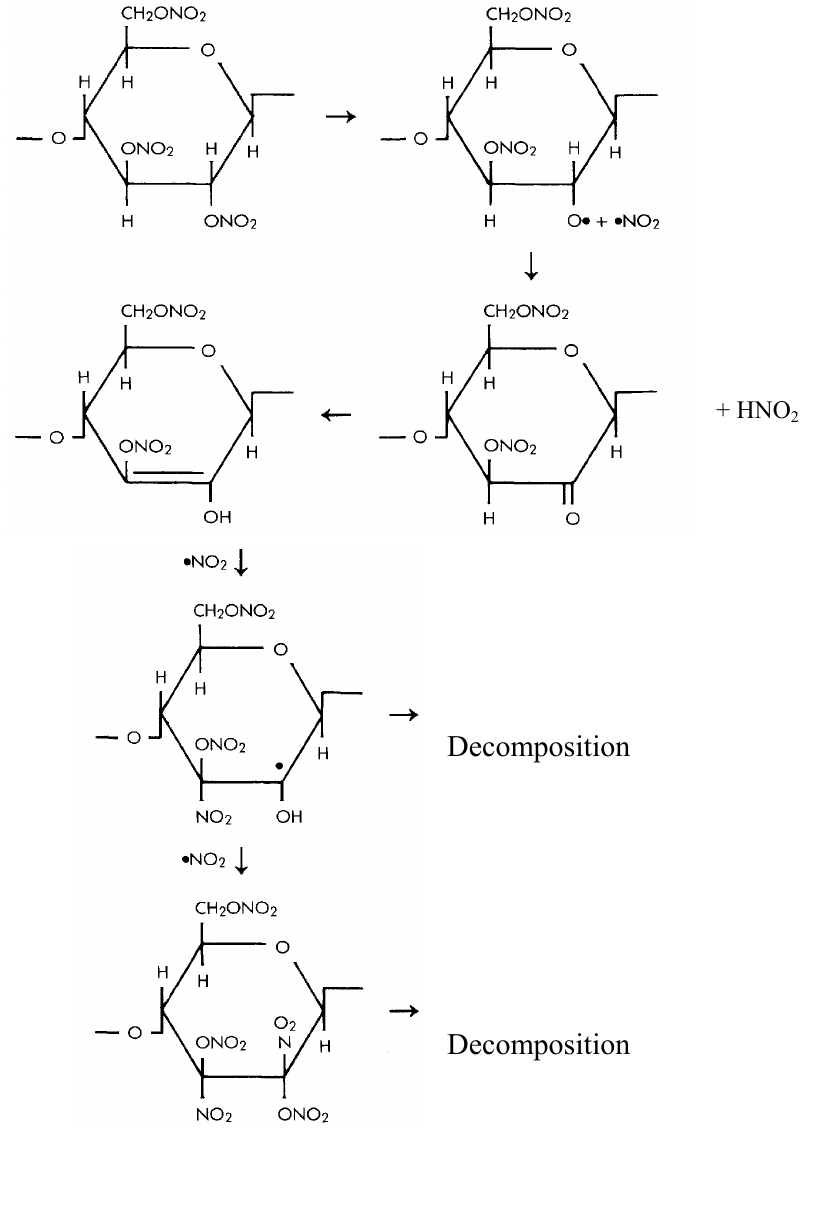
Figure 1. Pathways of secondary